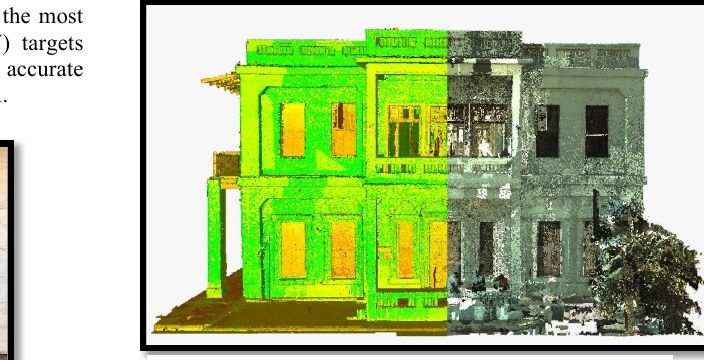
Figure 9: The 3-D point cloud